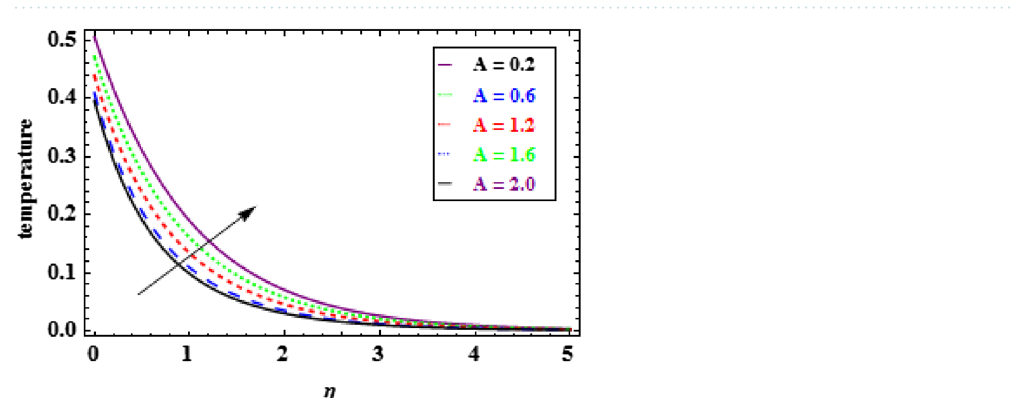
Figure 3. Inspiration of A on velocity.